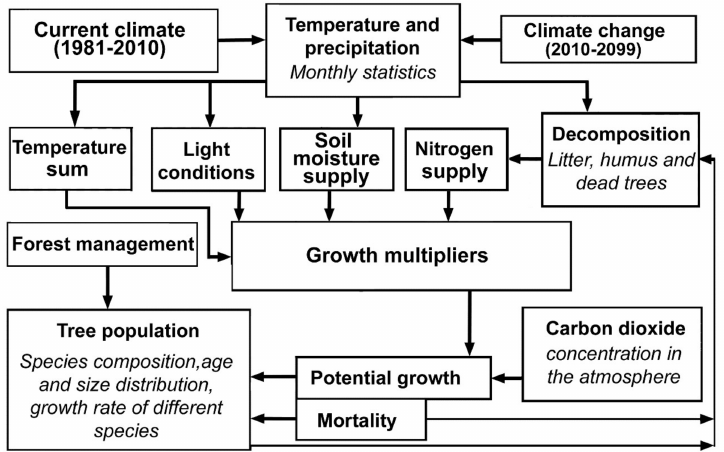
Figure 1. Outlines for the forest ecosystem model SIMA used in the